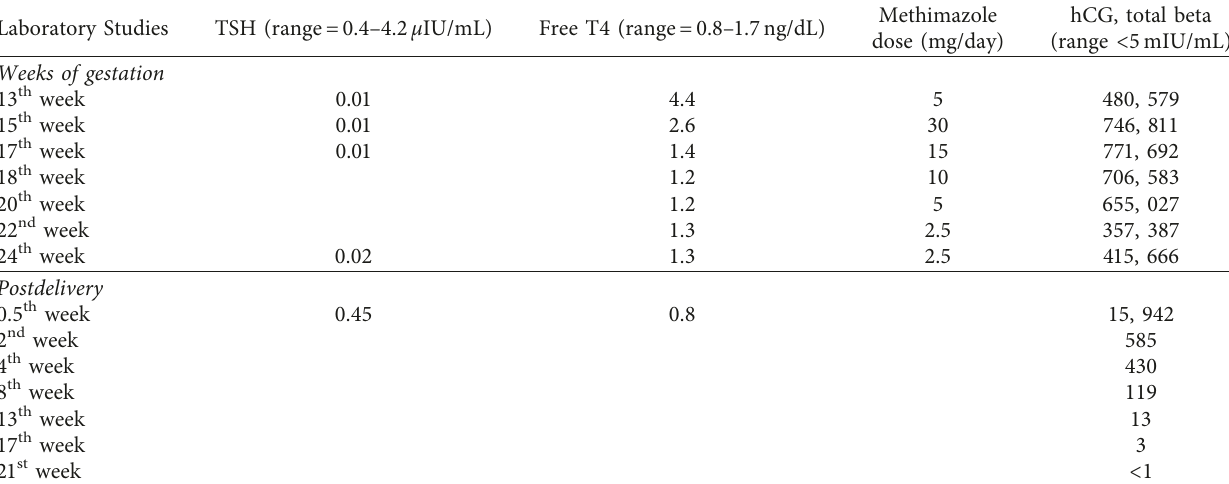
Table 2: TSH, free T4, and hCG trends during and